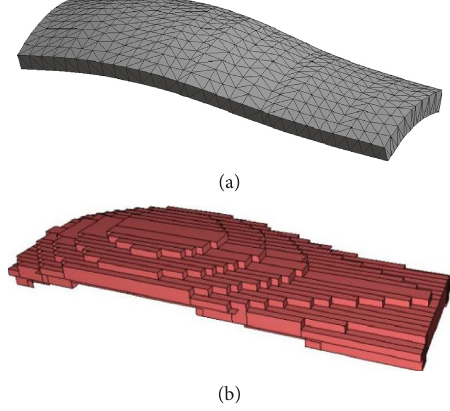
Figure 13: The curved roof models.